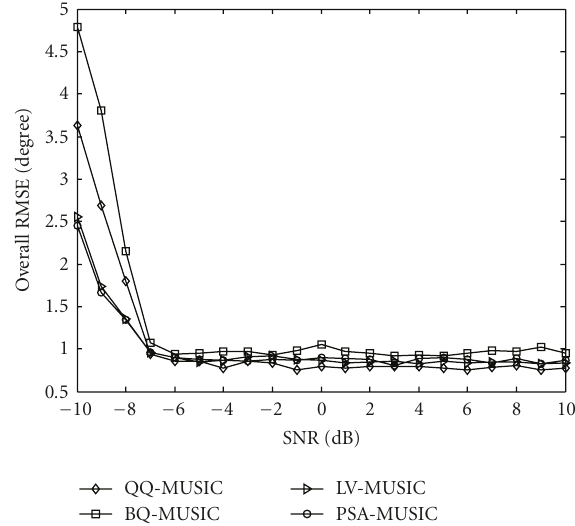
Figure 6: RMS estimation errors versus the power of sensor orientation error.